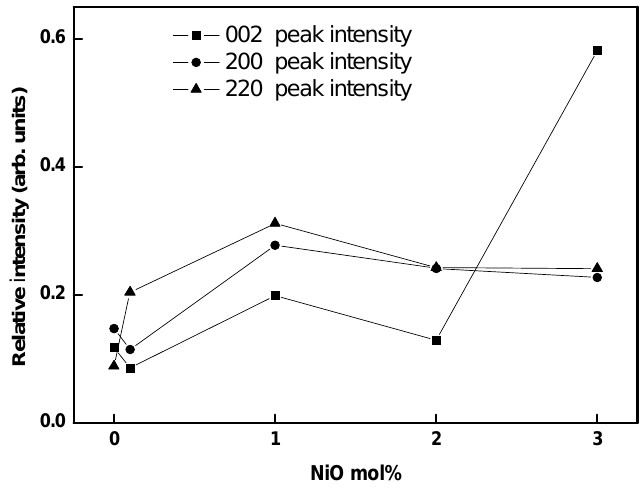
Figure 4 . XRD peak intensity variation as a function of NiO content (mol%) on 150nm WO thin film. 3 The grain growth was effectively inhibited by depositing NiO on WO thin film surfaces. Fig. 6 (a-d) 3 shows the surface morphology after a fixed amount of NiO (0.0009g, equivalent to 1.0, 0.75, 0.5 and 0.25 mol%) was deposited onto the respective films of 100, 120, 150 and 200nm (0.25, 0.5, 0.75, 1.0g films. NiO deposition was found to be inhibited the grain growth in only 100 and 120 nm weight) WO 3 films (c, d) as observed in the figure. Moreover, the crack films (a, b), but not in 150 and 200nm WO 3 gap was increased with WO thickness above 120nm. It means that 1.0-0.75mol% NiO addition could 3 effectively able to control the surface cracks of 100-120nm thickness WO films, and below or above 3 thickness, surface cracks were not inhibited as seen in Figs. 6 (c) this critical range of NiO and WO 3 and (d). Thus, this is one limitation of inhibition of grain growth in NiO deposited WO thin films. 3 150nm WO thin films and observed SEM surface morphologies as in Fig. 7 (a-c). It is observed 3